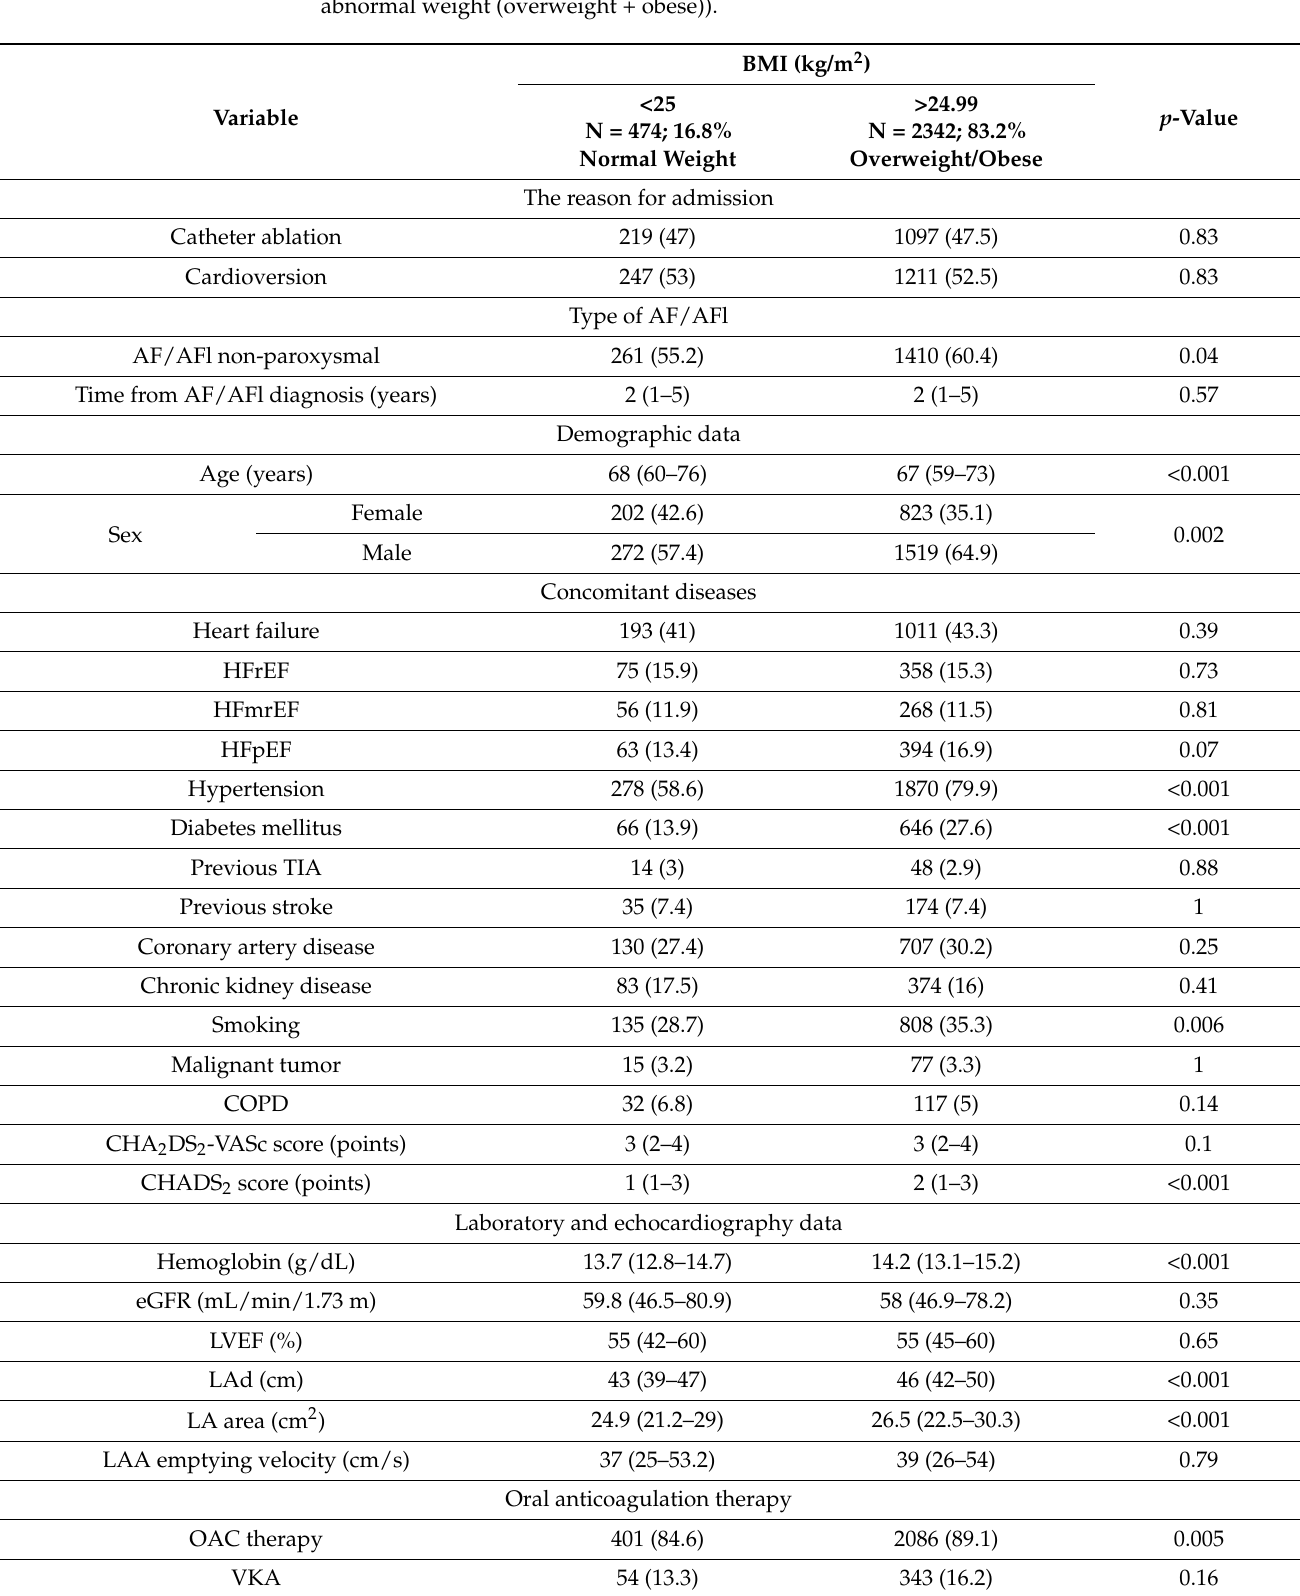
Table 2. Characteristics of the study group according to body mass index category (normal vs. abnormal weight (overweight +